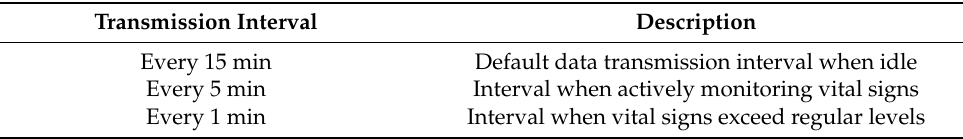
Table 1. Transmission interval between mobile device and server.